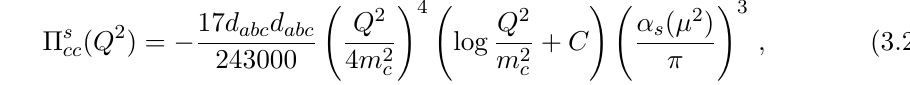
) = 0 . 1184 has been Z